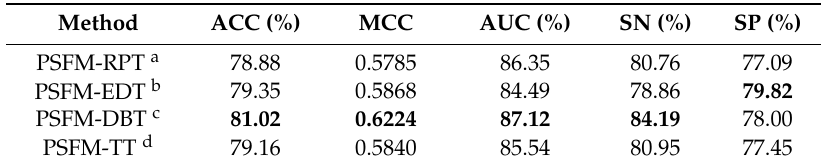
Table 1. The results of the four Position Specific Frequency Matrix (PSFM)-based methods on the benchmark dataset.